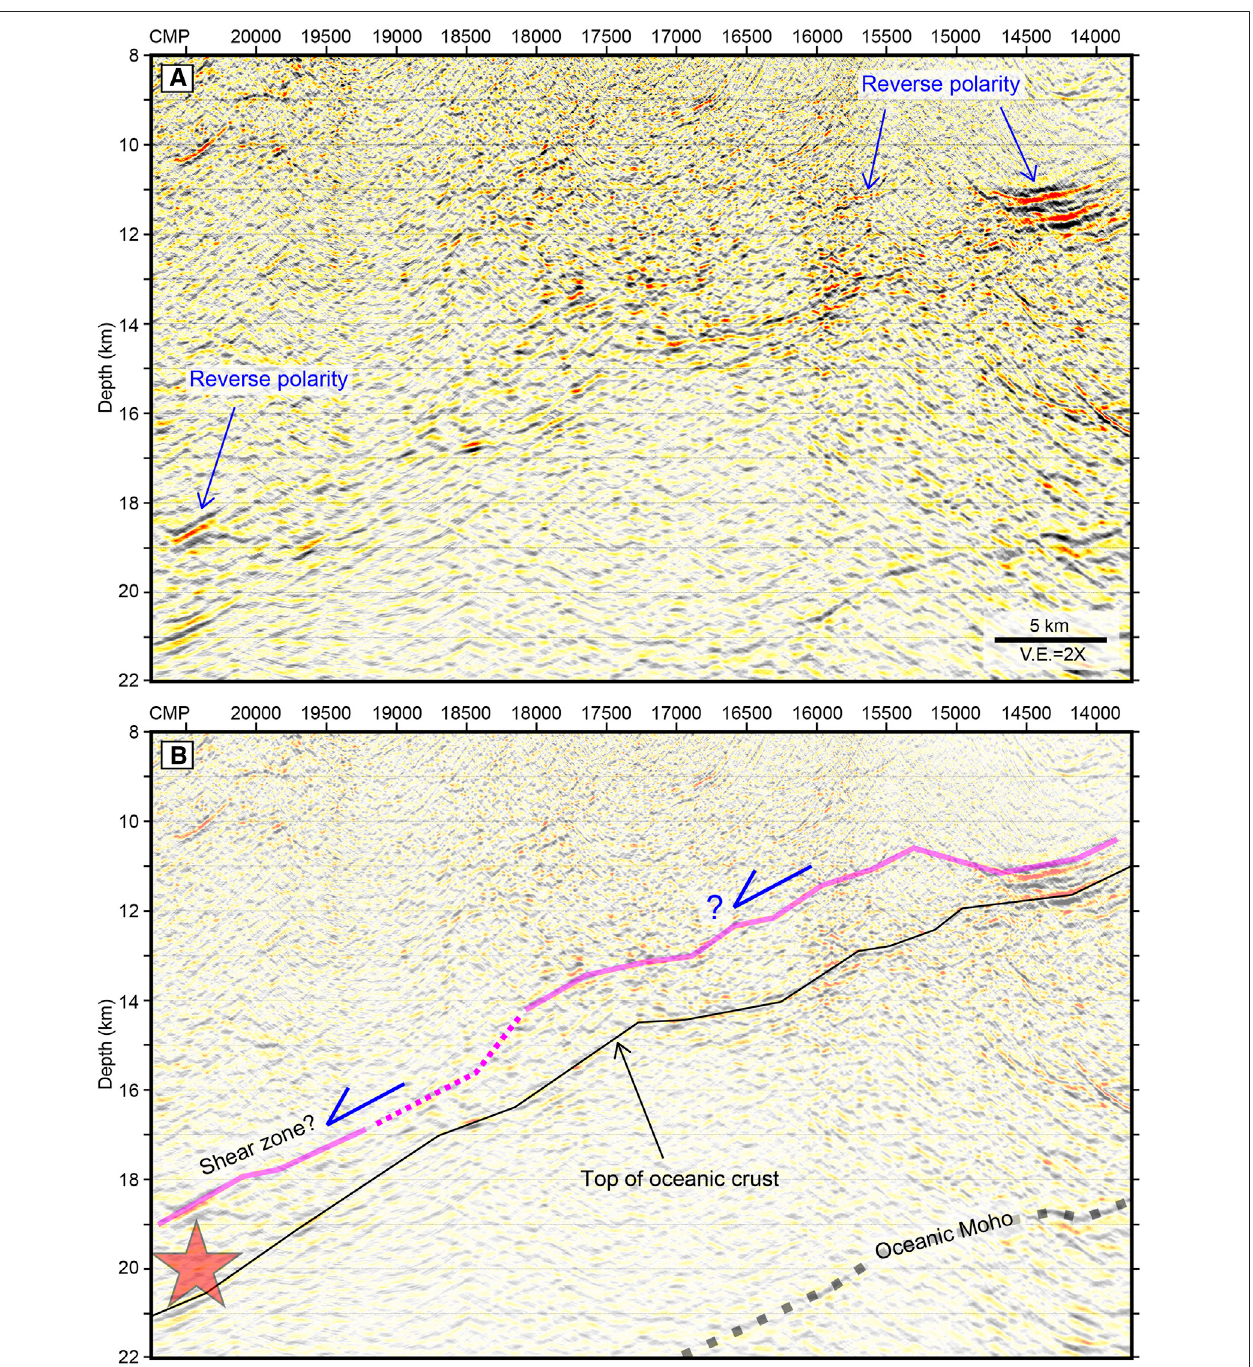
FIGURE7 | Enlarged PSDM section on line D6 and its interpretation showing a possible shear zone in the middle slope region. The section location ispresented in Figure2B . (A) Uninterpreted PSDMsection. High-amplitude, reverse-polarityre fl ections (black – red – black) oftheshearzone (thickpink)above thetopofoceaniccrust. (B) Interpreted PSDM section. The red star marks the hypocenter of the 2011 Tohoku earthquake (M w 9.0).